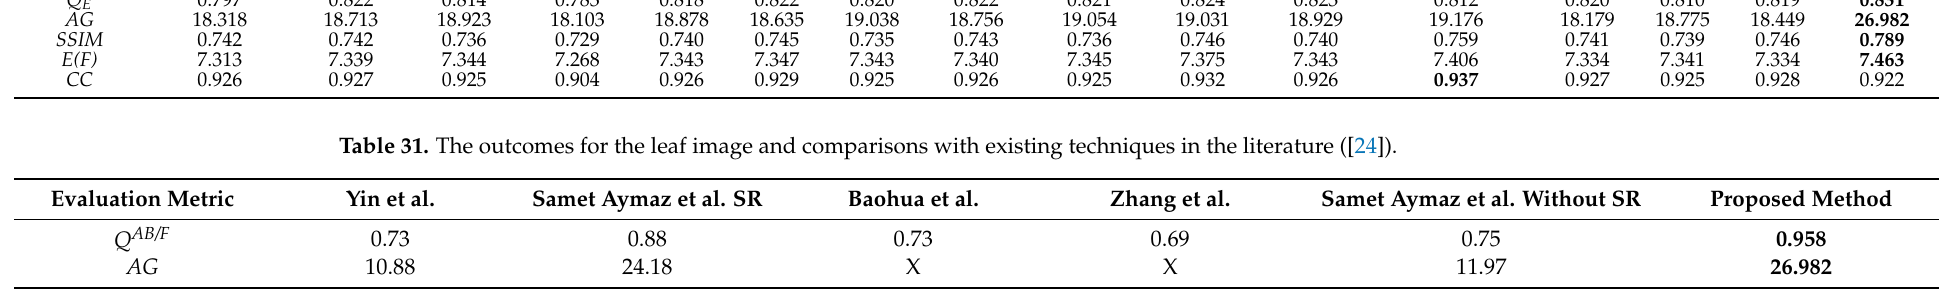
Table 32. The outcomes for the leaf image and comparisons with existing techniques in the literature ([30]). Evaluation Metric